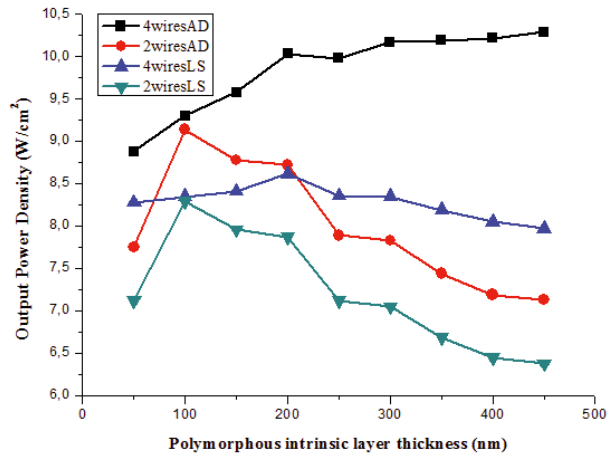
Fig. 5. Maximum output power of elementary cells versus pm-Si:H i-layer thickness.